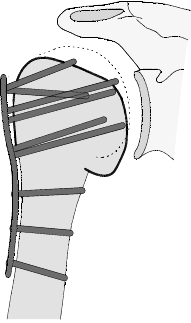
Figure 10. Complication Type 2a. Pattern image. Moderate grade varus displacement of the humeral head after angular stable plate osteosynthesis is illustrated by the transition of the dashed drawing (initially correct humeral head position) to the prominent black drawing with screw cutout (double).